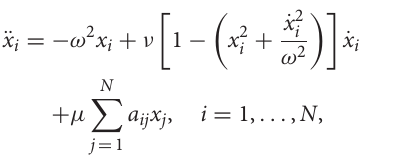
0, ω 1.0, N 20 and N 1 = = =